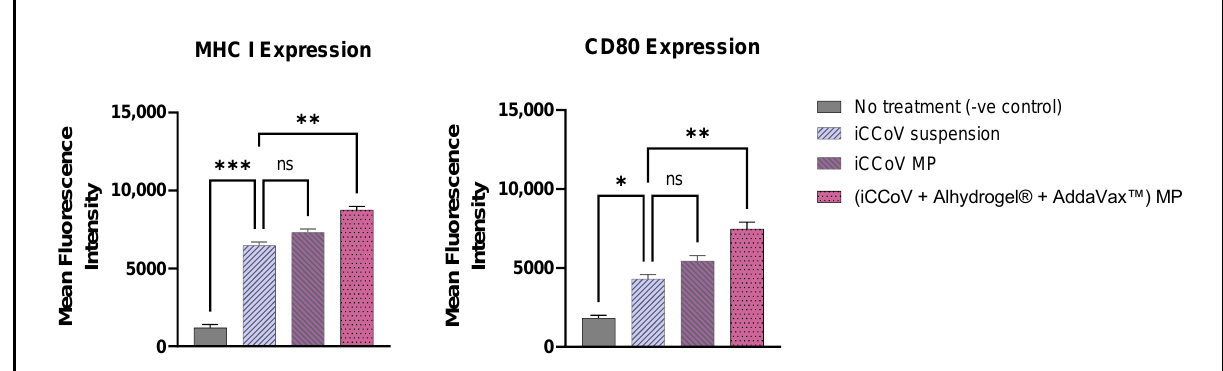
Figure 6. Expression of MHC I and CD80 on the surface of murine DCs pulsed with various groups . Cells were plated at a density of 3 × 10 4 cells/well. The cells were exposed to the following treatment groups for 24 h: No Treatment (- ve control), iCCoV suspension (2 μg), iCCoV MP (2 μg), and iCCoV MP (2 μg) + Alhydrogel ® MP (3 μg) + AddaVax™ (0.5 μg) MP. Data are expressed as Mean ± SEM ( n = 3), One-way ANOVA test, Post hoc Dunnett’s multiple comparisons test, ns, non-significant, * p ≤ 0.05, ** p ≤ 0.01, *** p ≤ 0.001.